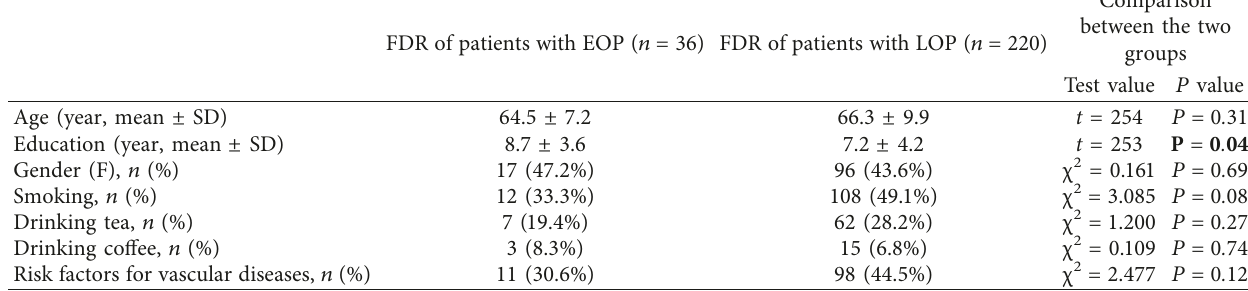
Table 1: Baseline data of the FDR of patients with EOP and LOP.